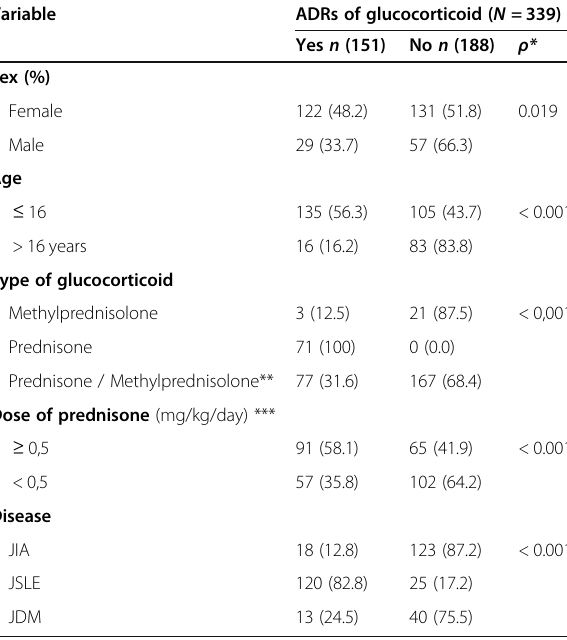
Table 3 Characteristics of patients who used methotrexate (MTX) and presented adverse drug reactions (ADRs) Variable